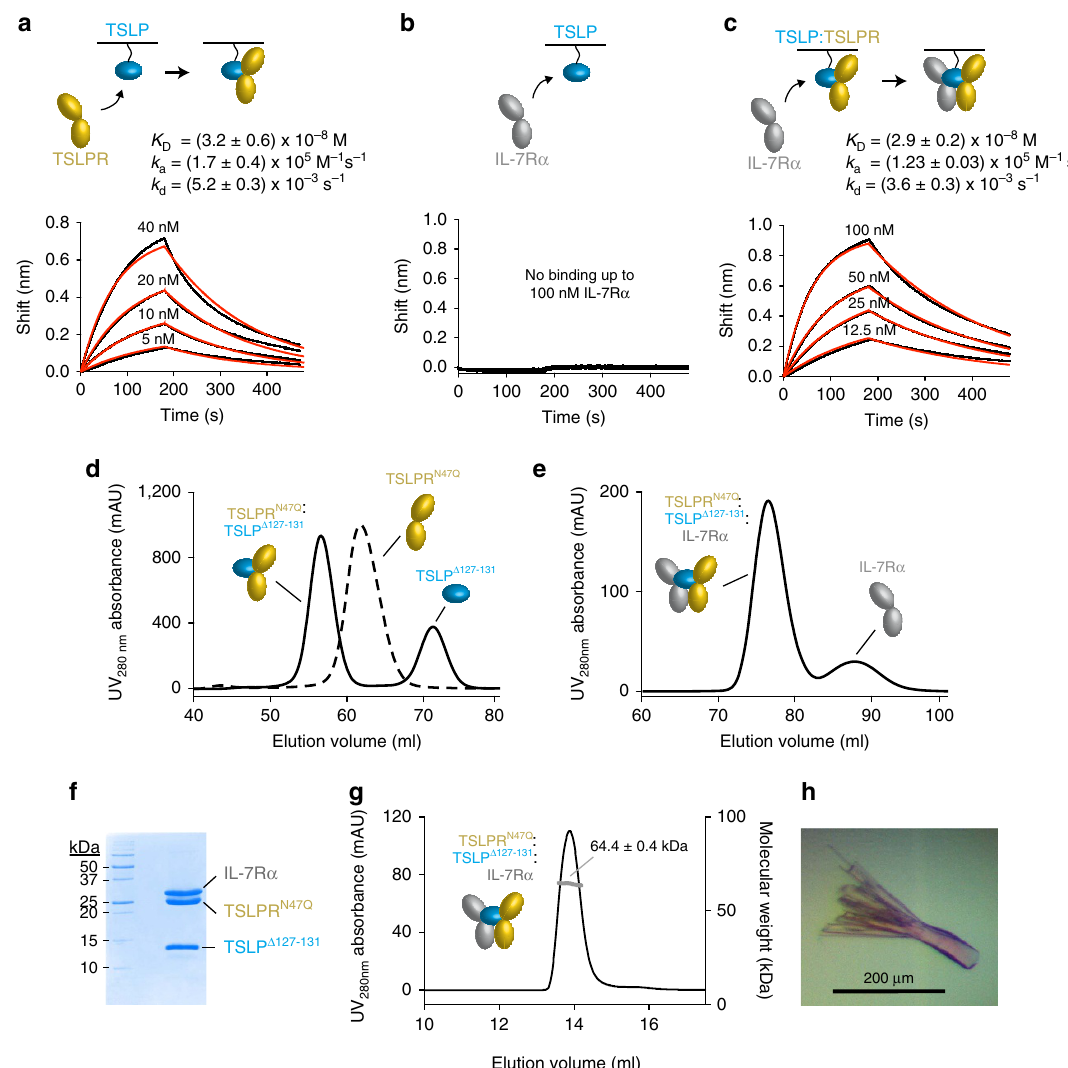
Figure 1 | The TSLP signalling complex assembles via a cooperative stepwise mechanism. ( a – c ) BLI data traces (black) and fitted 1:1 binding model (red) are plotted as the spectral nanometre shift in function of time for the interaction of TSLPR with TSLP ( a ), IL-7R a with TSLP ( b ) and IL-7R a with preformed TSLP:TSLPR complex ( c ). 4nm of biotinylated TSLP was loaded for experiments ( a – c ). In experiment ( c ) TSLP-coated biosensors were incubated with 320nM TSLPR and 320nM of TSLPR was included in kinetics buffer and IL-7R a samples. The reported K D -, k a - and k d -values represent average values and their s.d. from three technical replicate experiments. ( d ) SEC elution profiles on a Superdex 75 16/600 column of EndoH-treated TSLPR N47Q (dashed line) and TSLP D 127–131 :TSLPR N47Q complex (solid line) plotted as the ultraviolet absorbance at 280nm in function of elution volume. ( e ) SEC elution profile on a Superdex 200 16/600 column of TSLP D 127–131 :TSLPR N47Q :IL-7R a complex plotted as the ultraviolet absorbance at 280nm in function of elution volume. ( f ) Coomassie-stained reducing SDS–PAGE gel of glycan-minimized ternary complex used for crystallization trials. The theoretical protein molecular weights for IL-7R a , TSLPR and TSLP are 25.7, 24.0 and 14.6kDa. ( g ) SEC elution profile on a Superdex-200 10/300 GL column of glycan-minimized ternary TSLP complex plotted as the ultraviolet absorbance at 280nm (left Y -axis) as a function of elution volume. The molecular weight (right Y -axis) as determined by MALLS is reported as the number average molecular mass and its s.d. ( h ) Crystals of the TSLP D 127–131 :TSLPR N47Q :IL-7R a